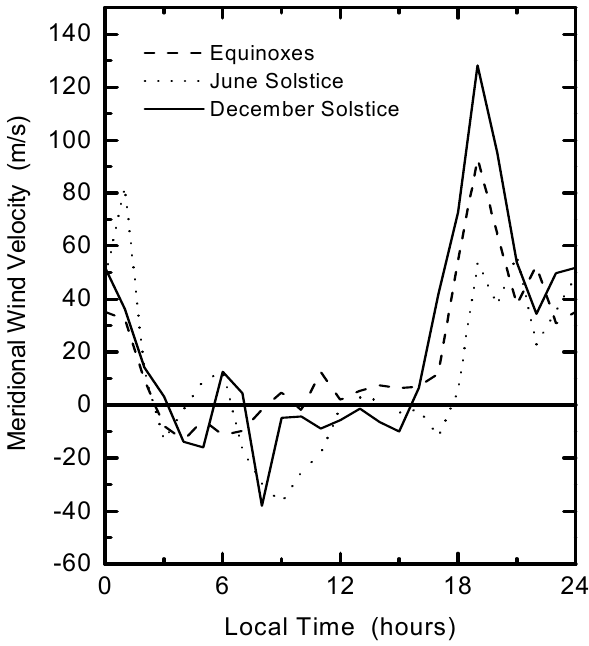
Figure 3. Fig. 3. Meridional neutral wind over Ouagadougou F-region iono-